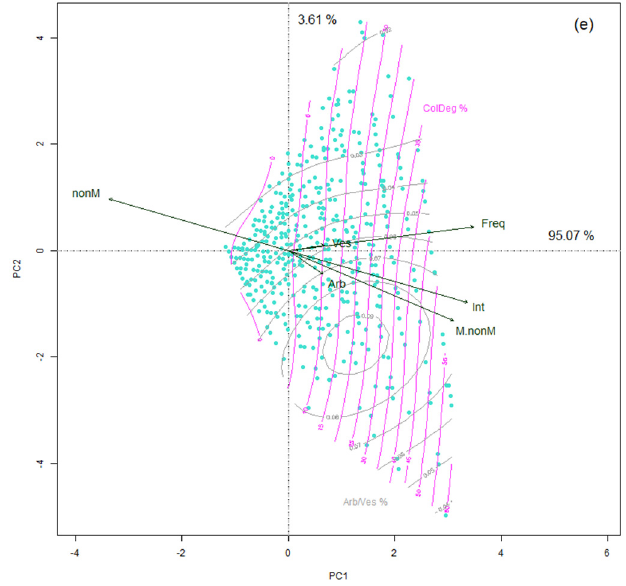
Figure 2. Principal Component Analysis of colonization parameters in A. capillaris due to applied treat- ments: ( a ) V1 (control variant)—untreated; ( b ) V2—organic (manure) treatment—10 t ha − 1 manure; ( c ) V3—low-mineral organic treatment—10 t ha − 1 manure + 50 N 25 P 2 O 5 25 K 2 O; ( d ) V4—mineral treatment—100 N 50 P 2 O 5 50 K 2 O; ( e ) V5—high-mineral organic treatment—10 t ha − 1 manure + 100 N 50 P 2 O 5 50 K 2 O. Legend: Freq—colonization frequency; Int—colonization intensity;